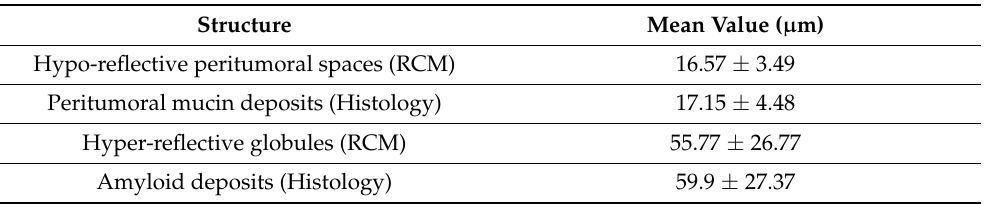
Table 1. Peritumoral hyporeflective cleft width and hyper-reflective globule sizes obtained by three random measurements in histological samples and RCM images of the